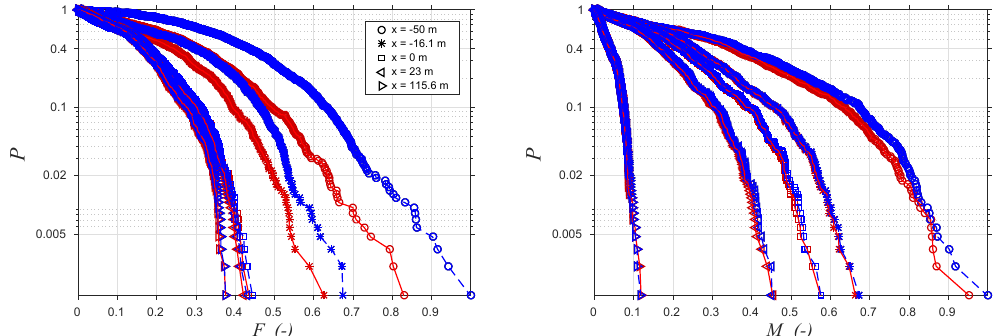
Figure 16. Probability of exceedance of the positive peaks in the time series of the sectional forces and moments for load case 1.3. The forces and moments are normalized with the largest force and moment peak at the seabed in the Flex5 calculation. Blue: Flex5. Red: QuLA.